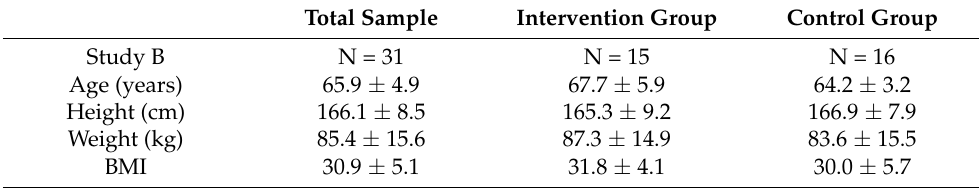
Table 5. Anthropometric data showing mean and standard deviation—Study B.